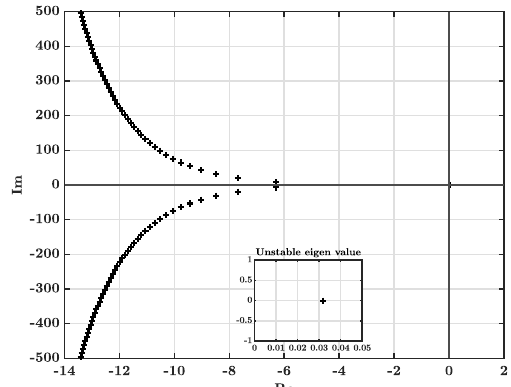
Figure 2. Eigenvalues distribution for unstable coupled ODE-PDE system when there is no diffusion within the tubular reactor.